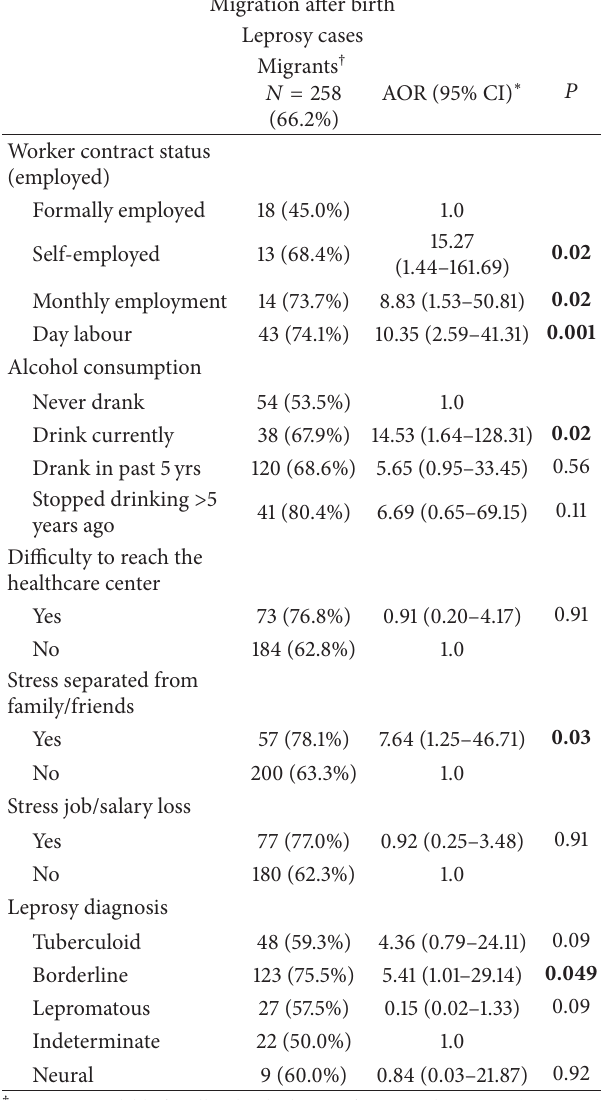
Table 2: Multivariate analysis of factors associated with migration after birth among migrants in a clinically unapparent population without symptoms of leprosy compared to clinically unapparent non-migrant